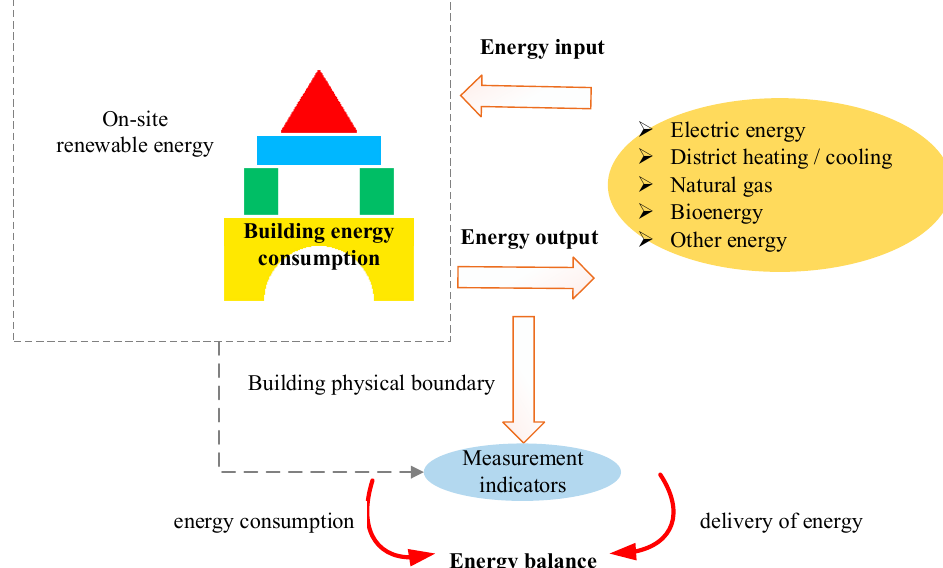
Figure 5. Schematic diagram of calculation boundary of zero-energy building.